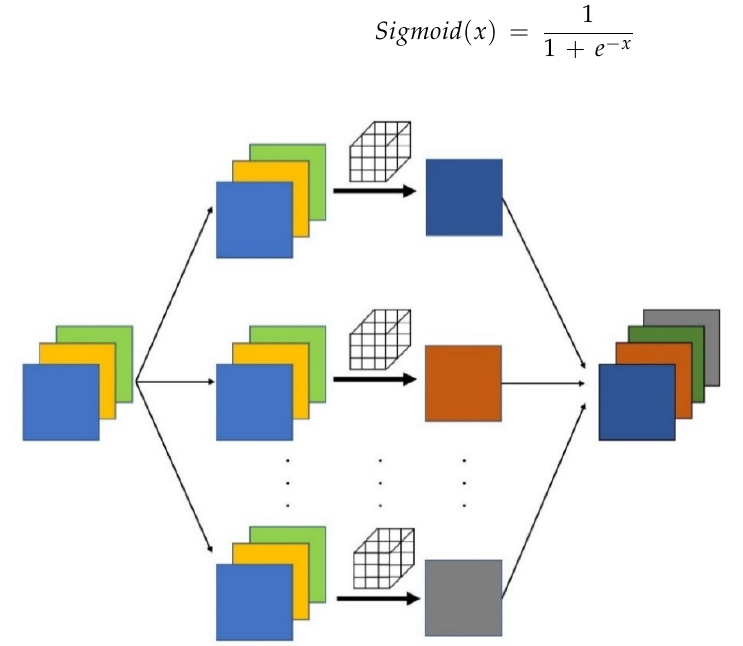
Figure 3. Explanatory drawing of the depthwise separable convolution operation.